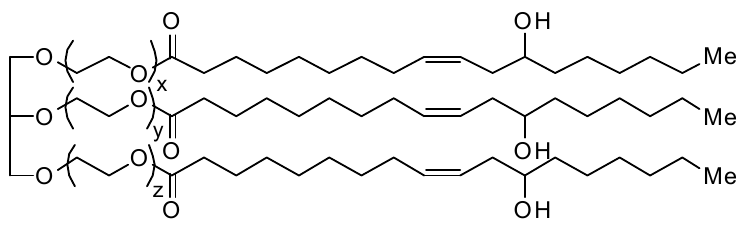
Figure 1. Chemical structure of Kolliphor EL.